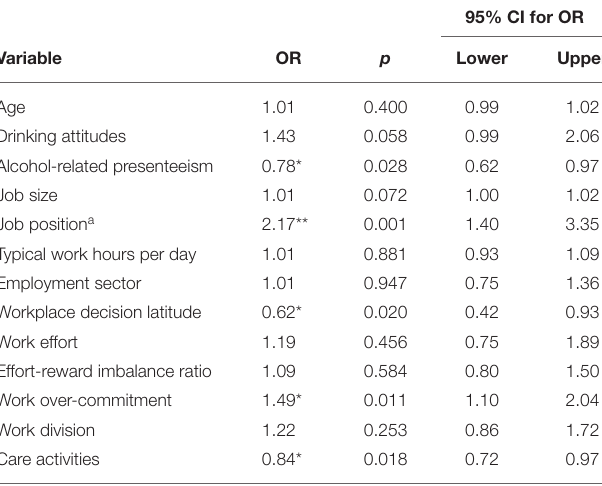
TABLE 3 | Adjusted associations with willingness to